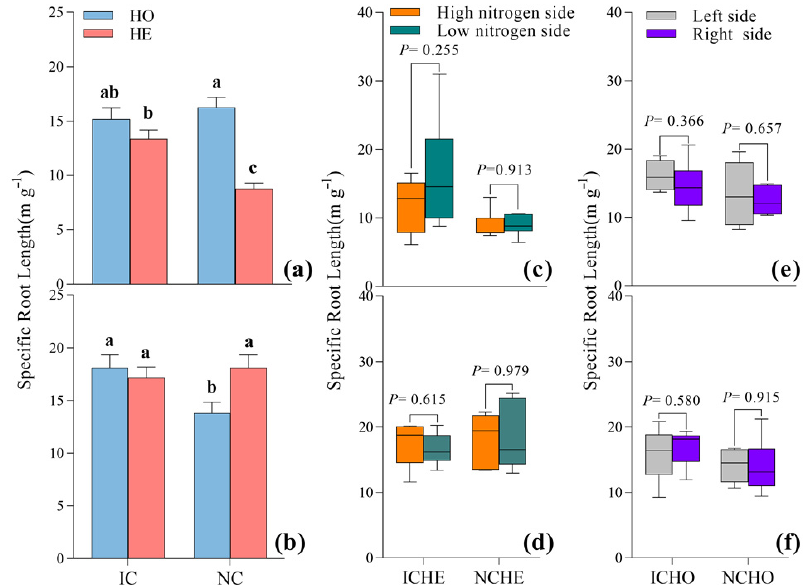
Figure 5. Effect of nitrogen distribution pattern and intraspecific competition on specific root length.